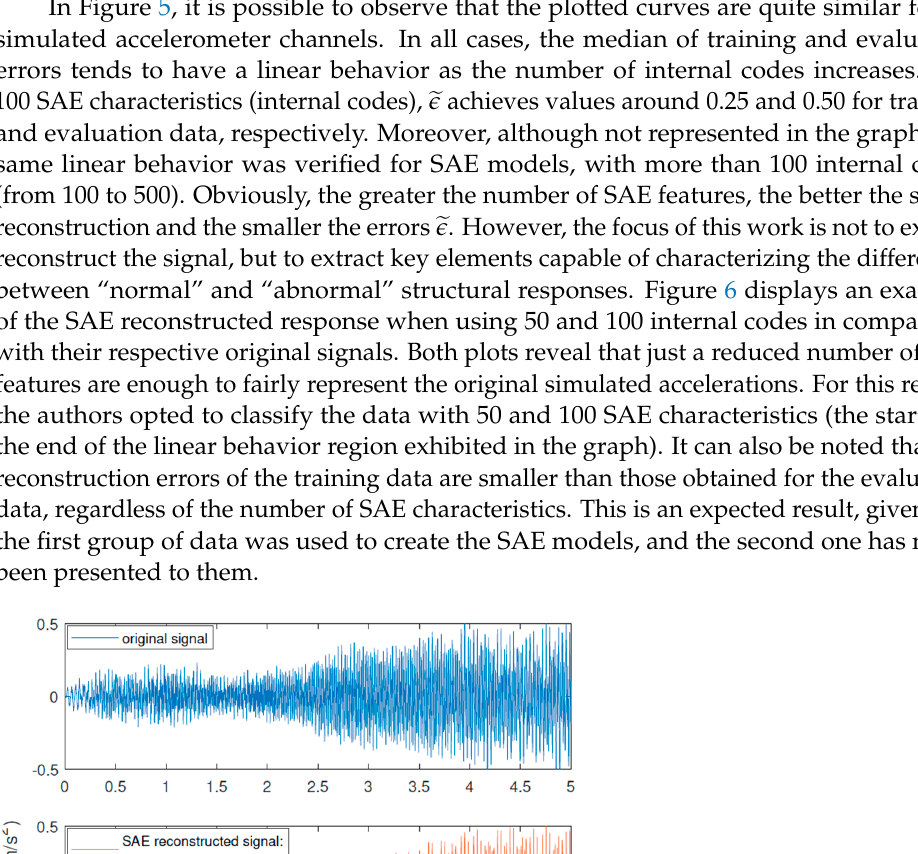
Table 3. Simply supported numerical beam: correct classification rates in percentage. Mean Max.